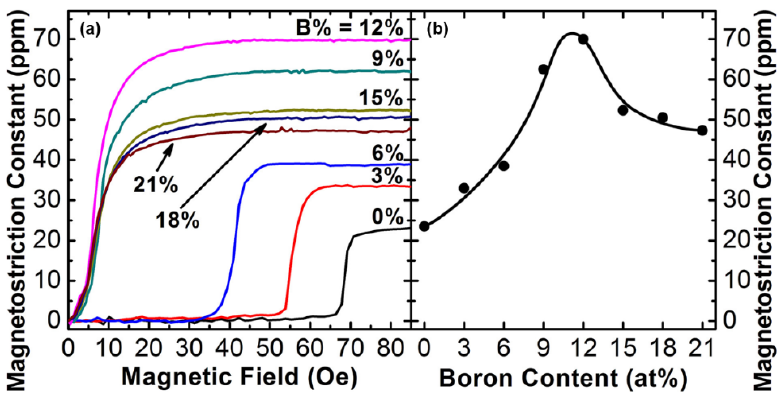
Figure 11. ( a ) Magnetostriction vs magnetic field. ( b ) Saturation magnetostriction constant vs B content. Reproduced with permission from [62]. Copyright [2007], American Institute of Physics.